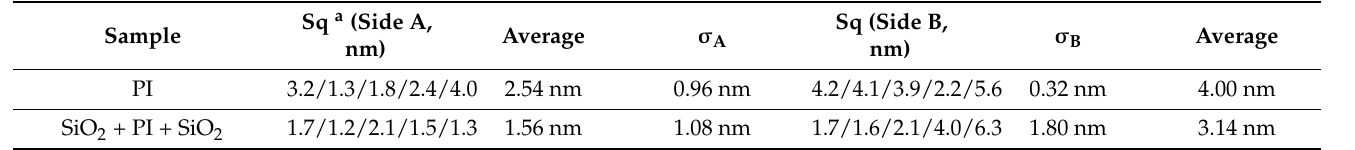
Figure 7. The surface roughness (Sq, nm) of PI membrane on side A and side B after coated with SiO 2 antireflective membrane on both sides. Table 2. The surface roughness results (Sq, nm) of PI membrane on side A and side B before and after coated with SiO 2 antireflective membrane on both